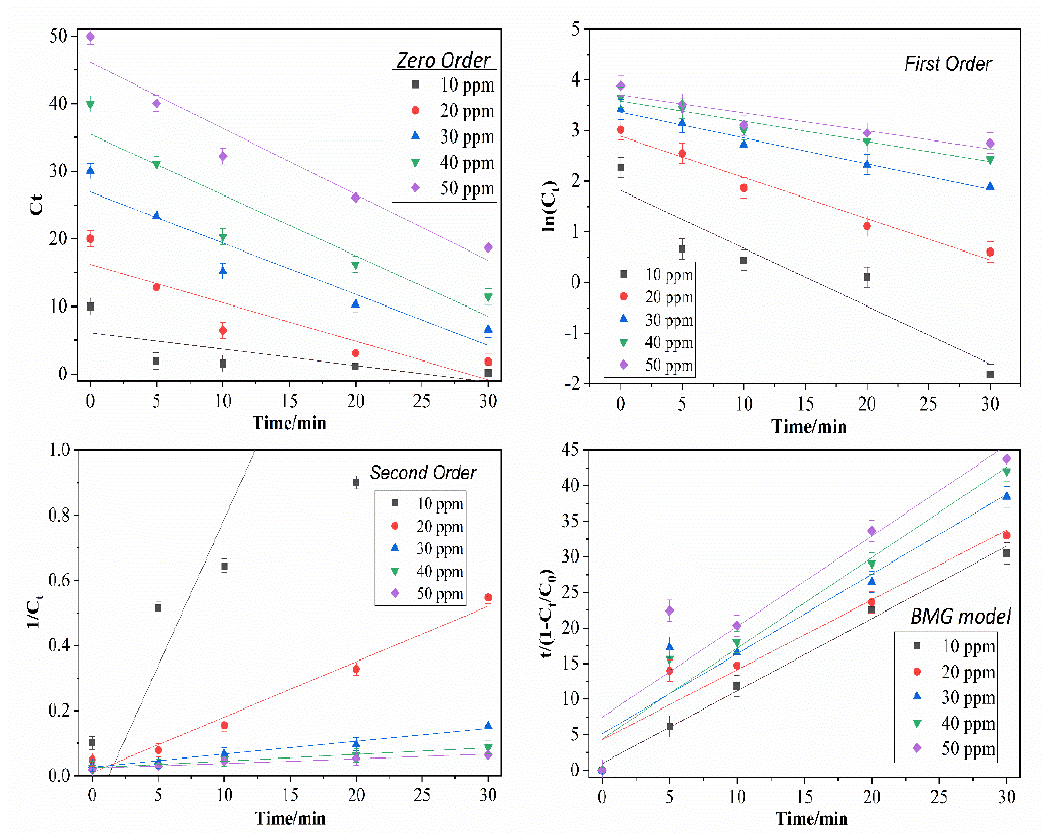
Figure 12. Degradation data of glyphosate using different kinetic models under different initial glyphosate concentrations.